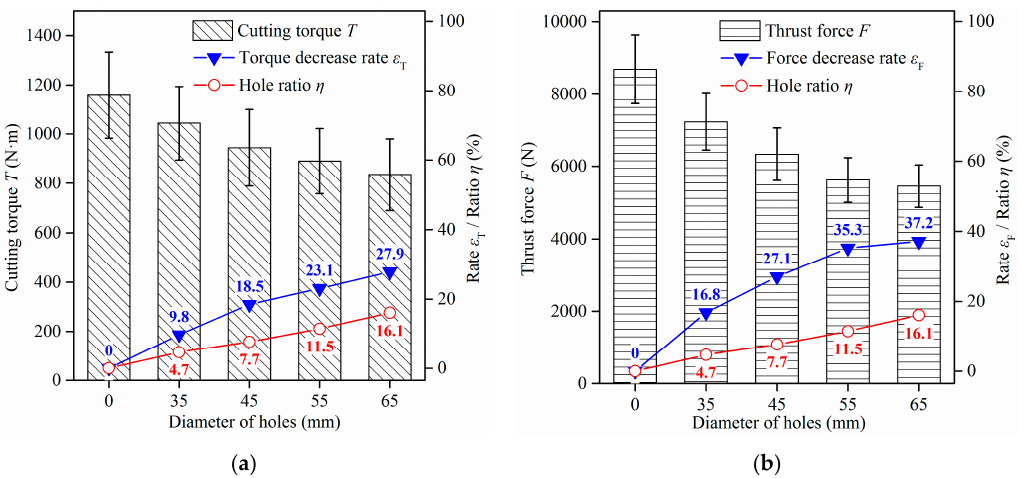
Figure 16. Effect of hole diameter on ( a ) cutting torque and ( b ) thrust force.